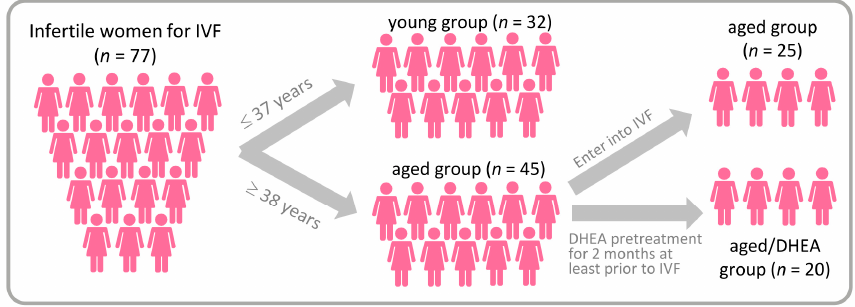
Figure 1. A flow chart showing the study design and selection of eligible studies. Table 1. Basic characteristics of patients in the young, aged, and aged/DHEA groups. Parameters